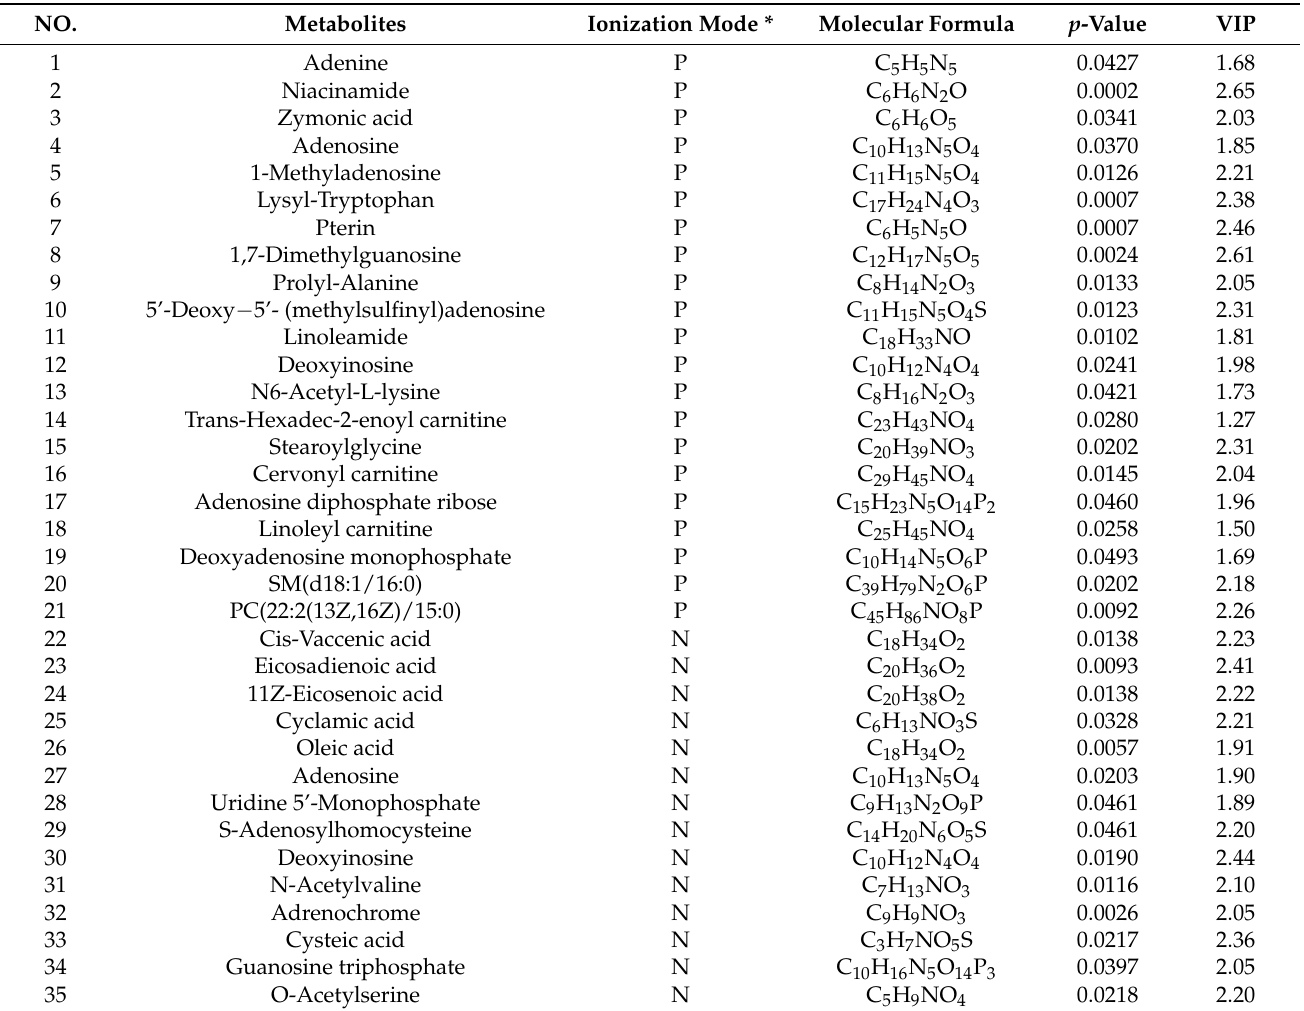
Table 3. Differential metabolites of high-fat cells in FBBE-PS group and the model